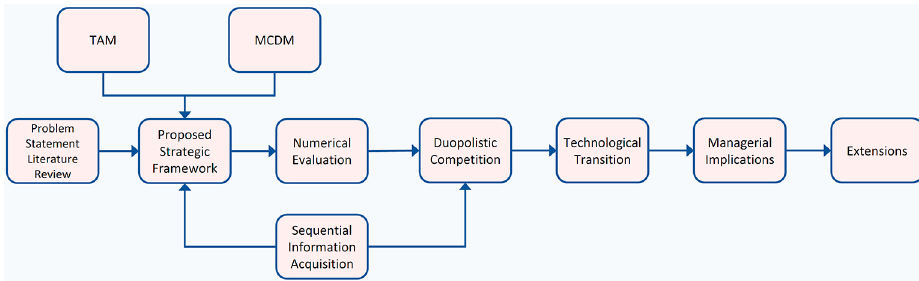
Figure 3. Structure of the current